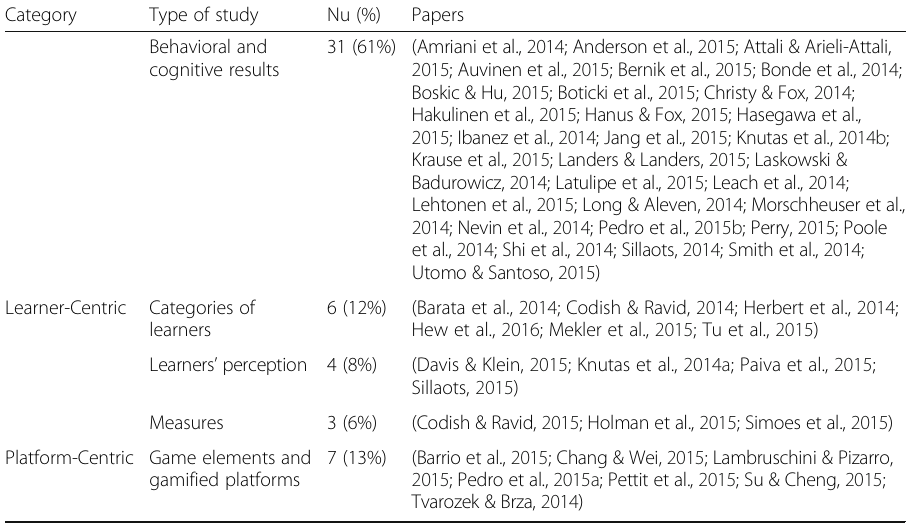
Table 8 Paper distribution according to the type of study Category Type of study Nu (%) Papers Behavioral and 31 (61%) (Amriani et al., 2014; Anderson et al., 2015; Attali & Arieli-Attali, cognitive results 2015; Auvinen et al., 2015; Bernik et al., 2015; Bonde et al., 2014; Boskic & Hu, 2015; Boticki et al., 2015; Christy & Fox, 2014; Hakulinen et al., 2015; Hanus & Fox, 2015; Hasegawa et al., 2015; Ibanez et al., 2014; Jang et al., 2015; Knutas et al., 2014b; Krause et al., 2015; Landers & Landers, 2015; Laskowski & Badurowicz, 2014; Latulipe et al., 2015; Leach et al., 2014; Lehtonen et al., 2015; Long & Aleven, 2014; Morschheuser et al., 2014; Nevin et al., 2014; Pedro et al., 2015b; Perry, 2015; Poole et al., 2014; Shi et al., 2014; Sillaots, 2014; Smith et al., 2014; Utomo & Santoso, 2015) Learner-Centric Categories of 6 (12%) (Barata et al., 2014; Codish & Ravid, 2014; Herbert et al., 2014; learners Hew et al., 2016; Mekler et al., 2015; Tu et al., 2015) Learners ’ perception 4 (8%) (Codish & Ravid, 2015; Holman et al., 2015; Simoes et al., 2015) Platform-Centric Game elements and gamified